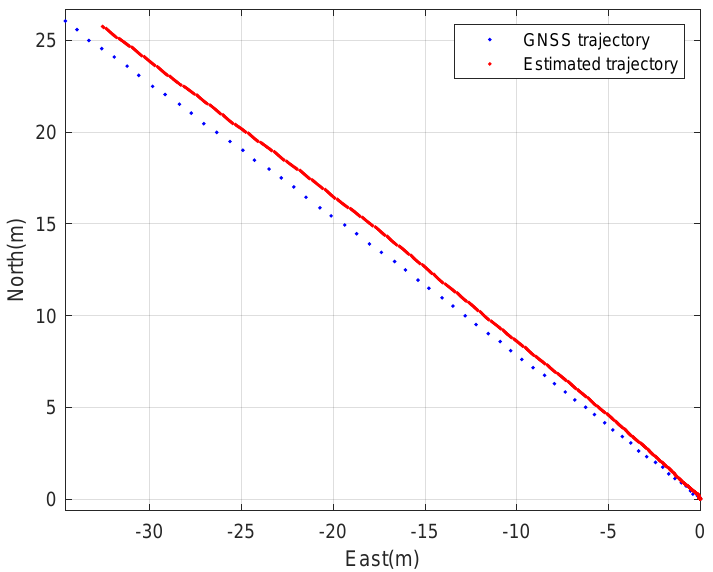
Figure 15. The 2D trajectory of the